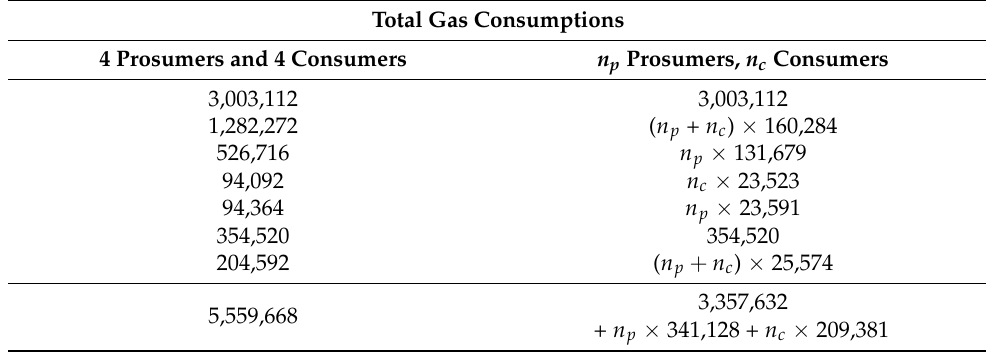
Table 9. Total gas consumptions per trading